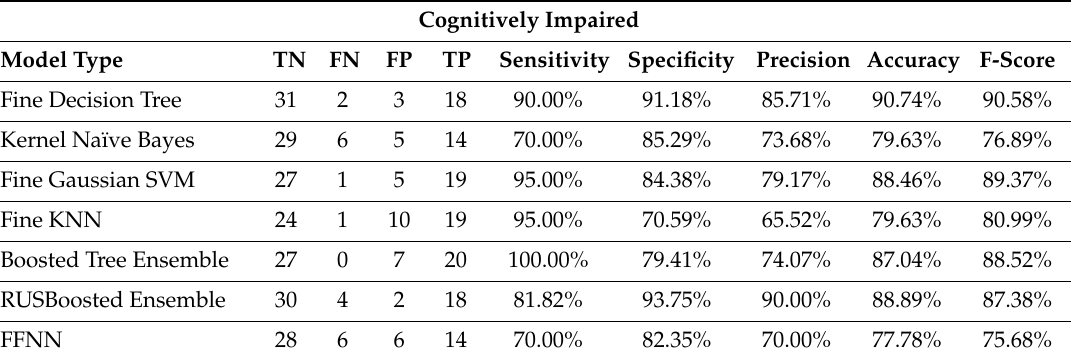
Table 6. Testing the models created from SMOTE